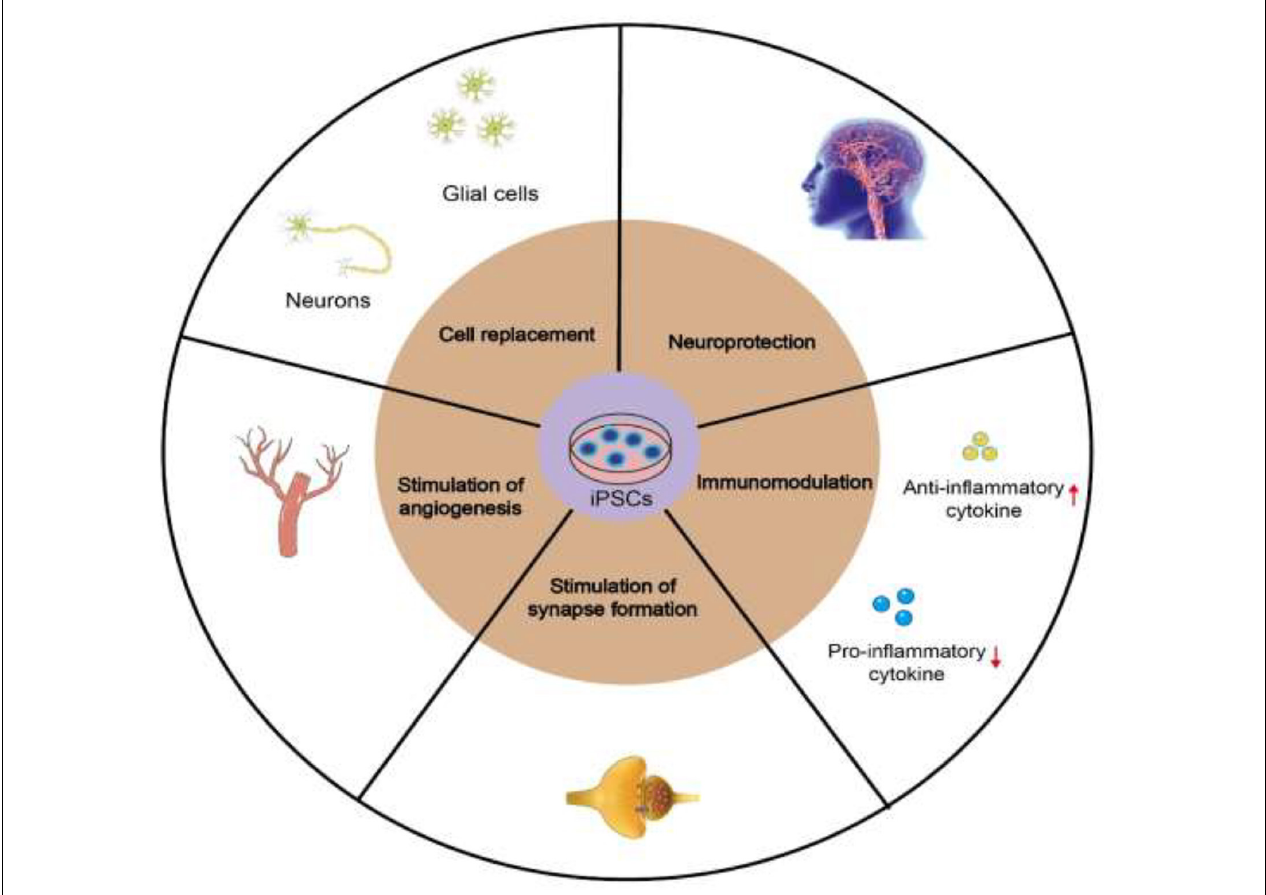
FIGURE 1 | Mechanisms of iPSCs in treating ischemic stroke, including cell replacement, neuroprotection, stimulation of angiogenesis, synaptogenesis and endogenous neurogenesis, and modulation of inflammatory and immune